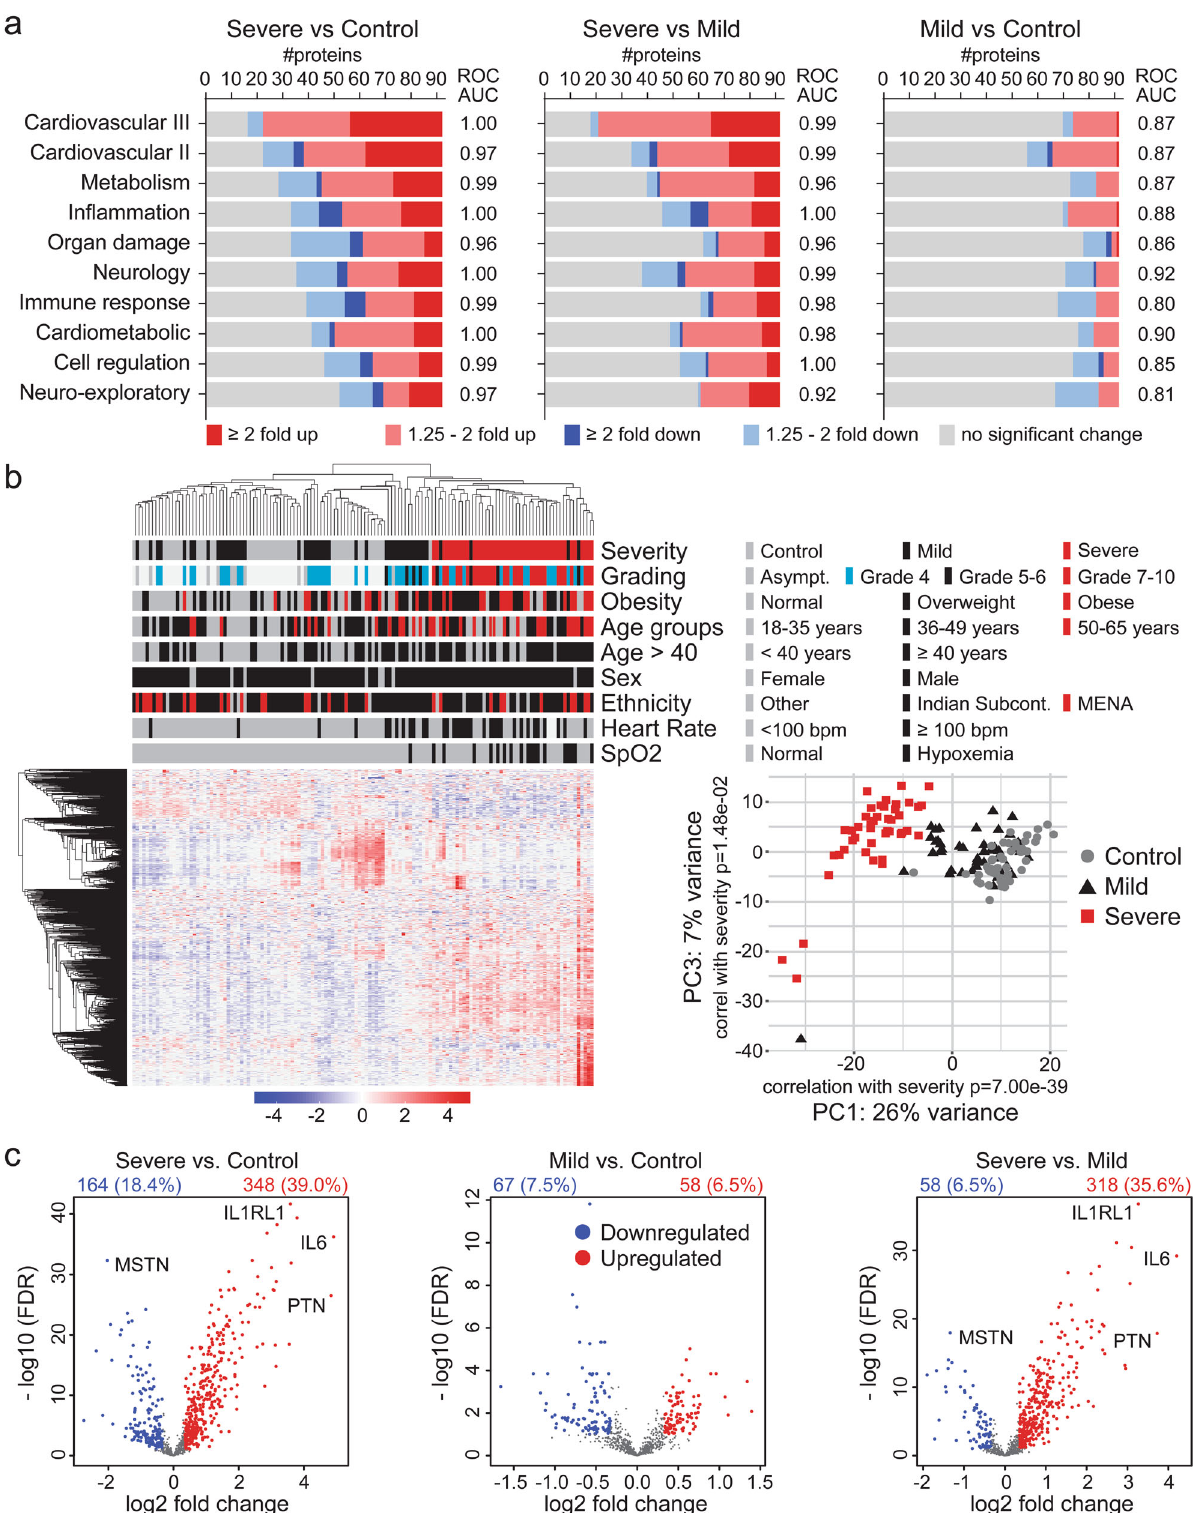
(PDI) was carried out based on the upregulated proteins sum- marized in Fig. 2 in patients with severe versus mild-moderate disease groups. The Drug-Gene Interaction database 11 (DGIdb, v4.2.0) was screened for FDA-approved drugs which interact with versus both the mild-moderate and control groups. We identi fi